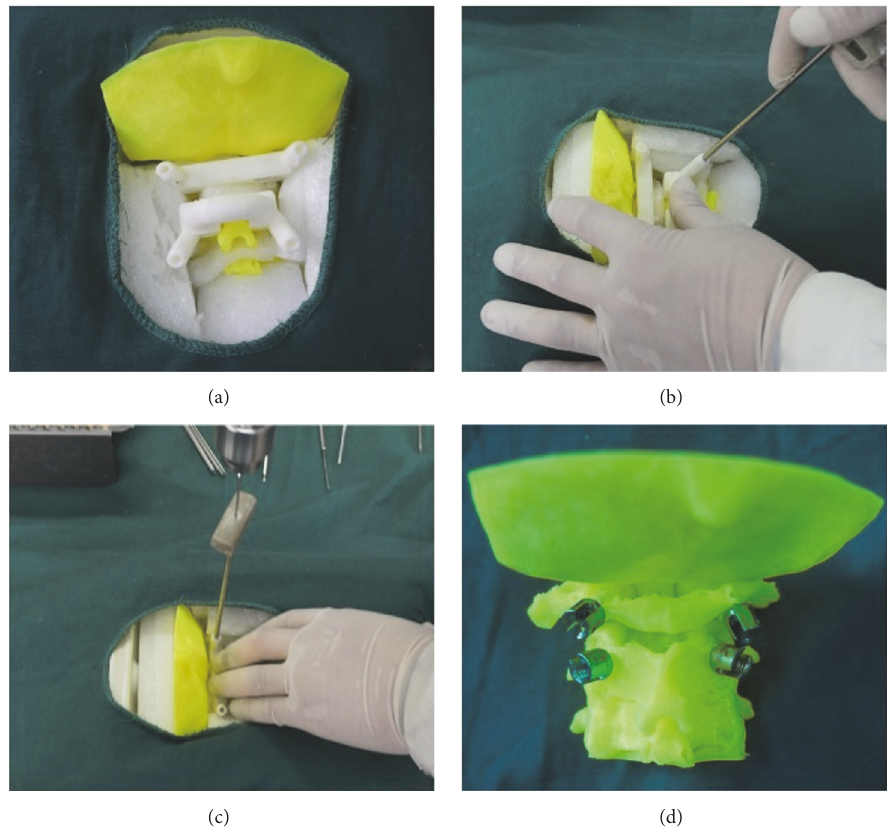
Figure 5: Navigation template-assisted pedicle screw fixation in upper cervical spine. (a) Navigation template pressed to fit with vertebra. (b) Placement of navigation protective sleeve. (c) Kirschner wire perforated along protective sleeve. (d) Pedicle screw fixation (source: reproduced and adapted with permission from Guo et al.).